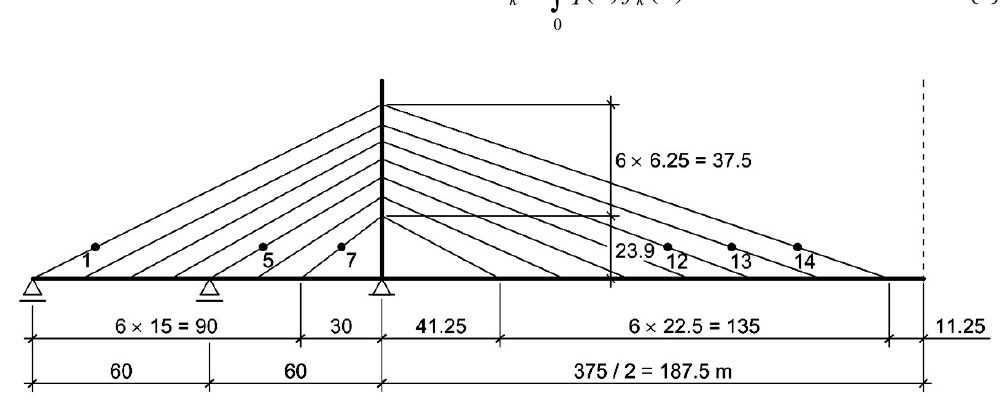
Figure 3. Details of bar/truss model geometry of the structure (one half of the bridge is shown). The numbers point at the cables equipped with force sensors. Cables Nos. 24 and 28 are symmetrical to the cables Nos. 1 and